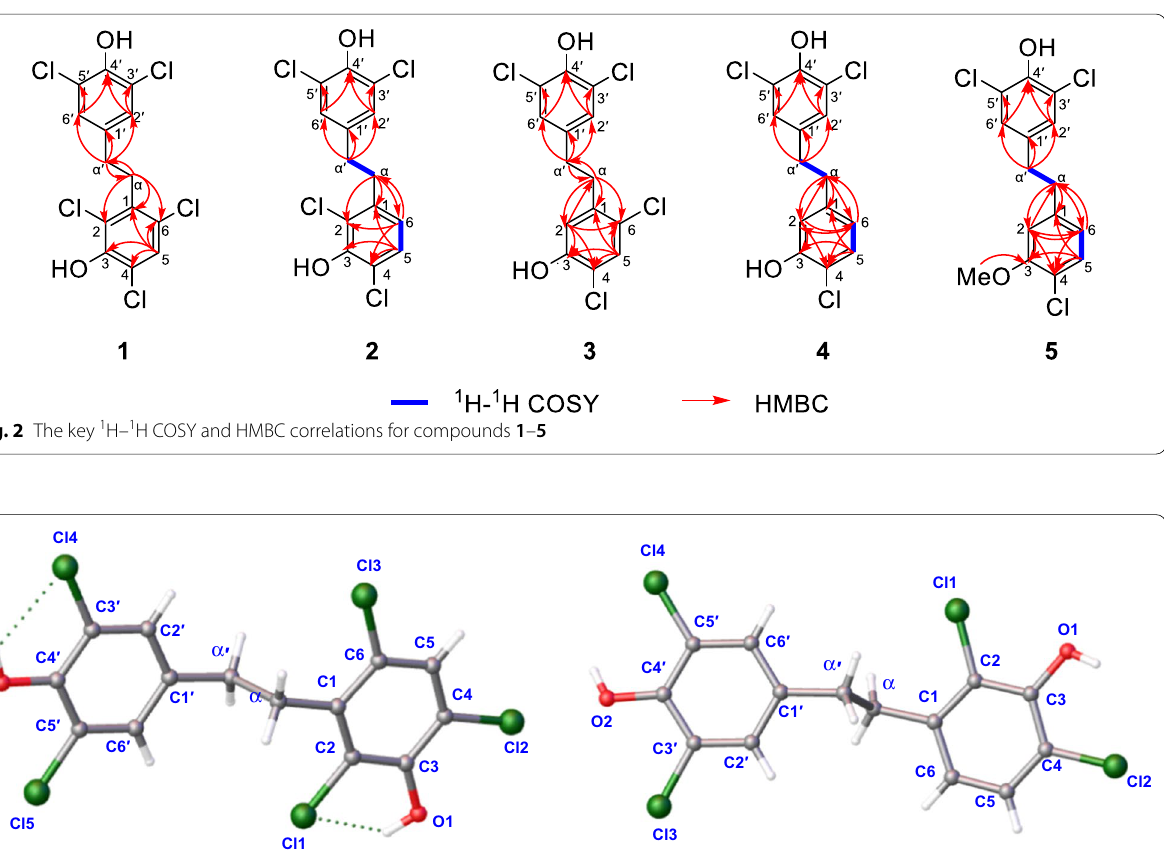
Fig. 3 X‑ray ORTEP drawing of 1 and